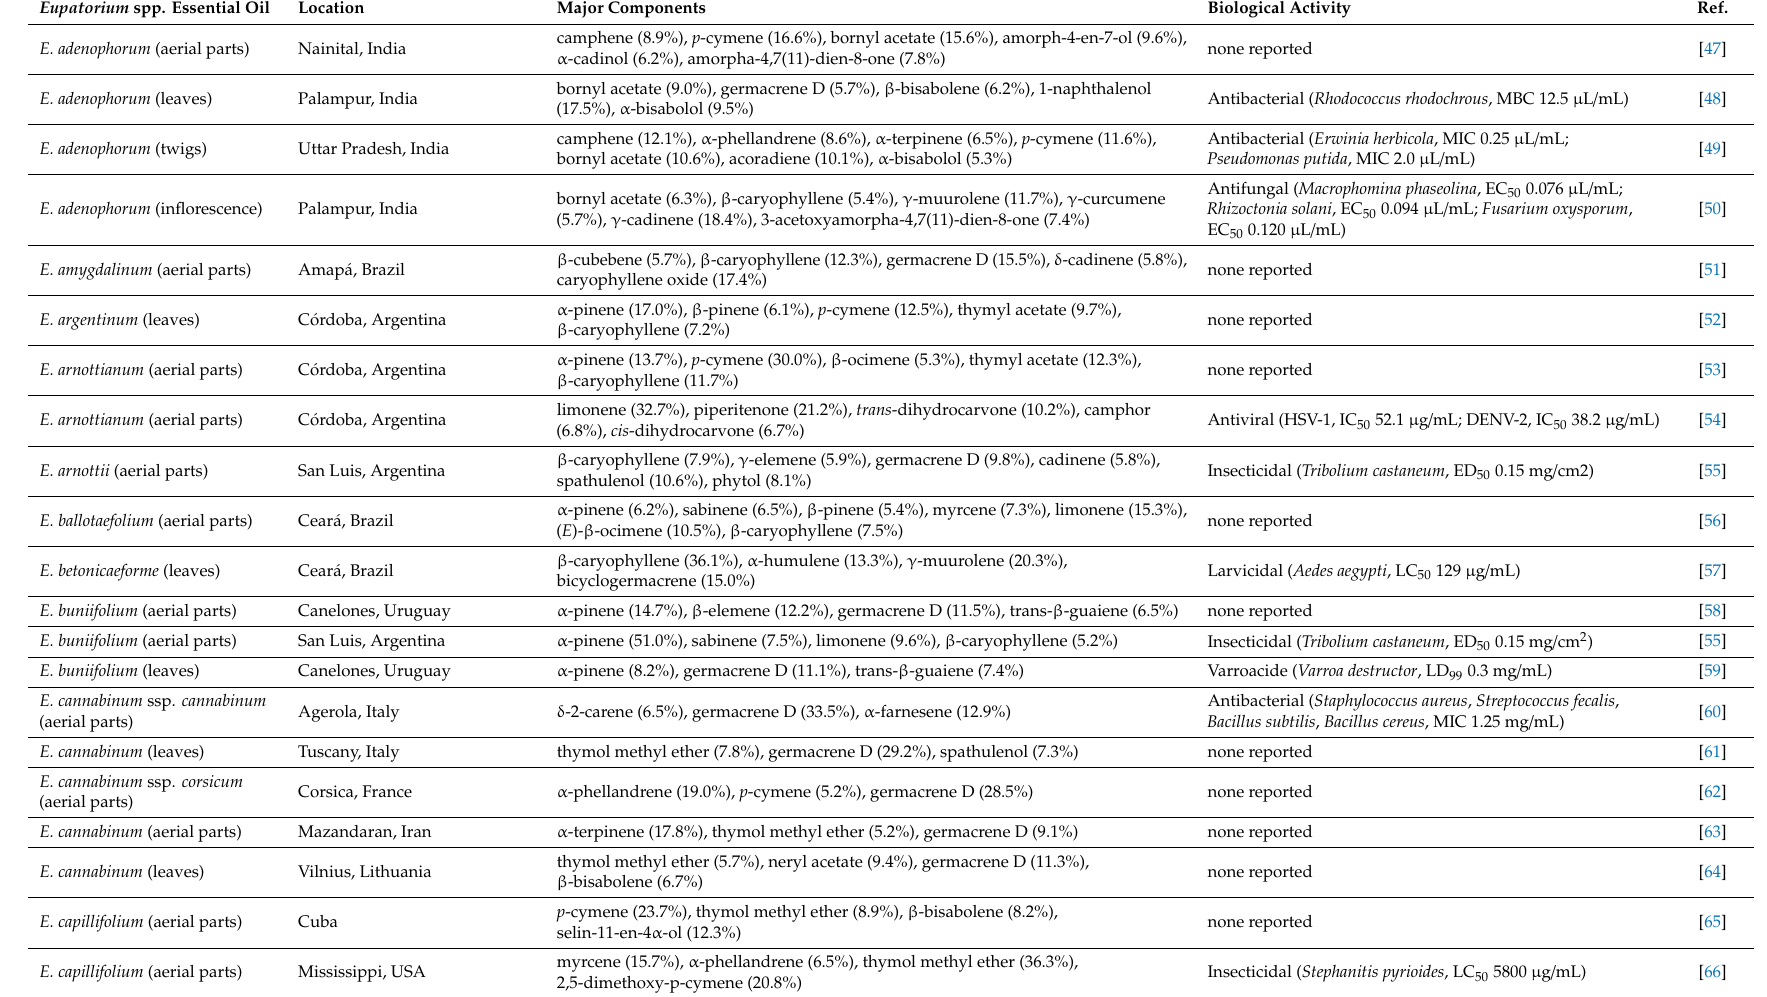
Table 2. Major components and biological activities of Eupatorium essential